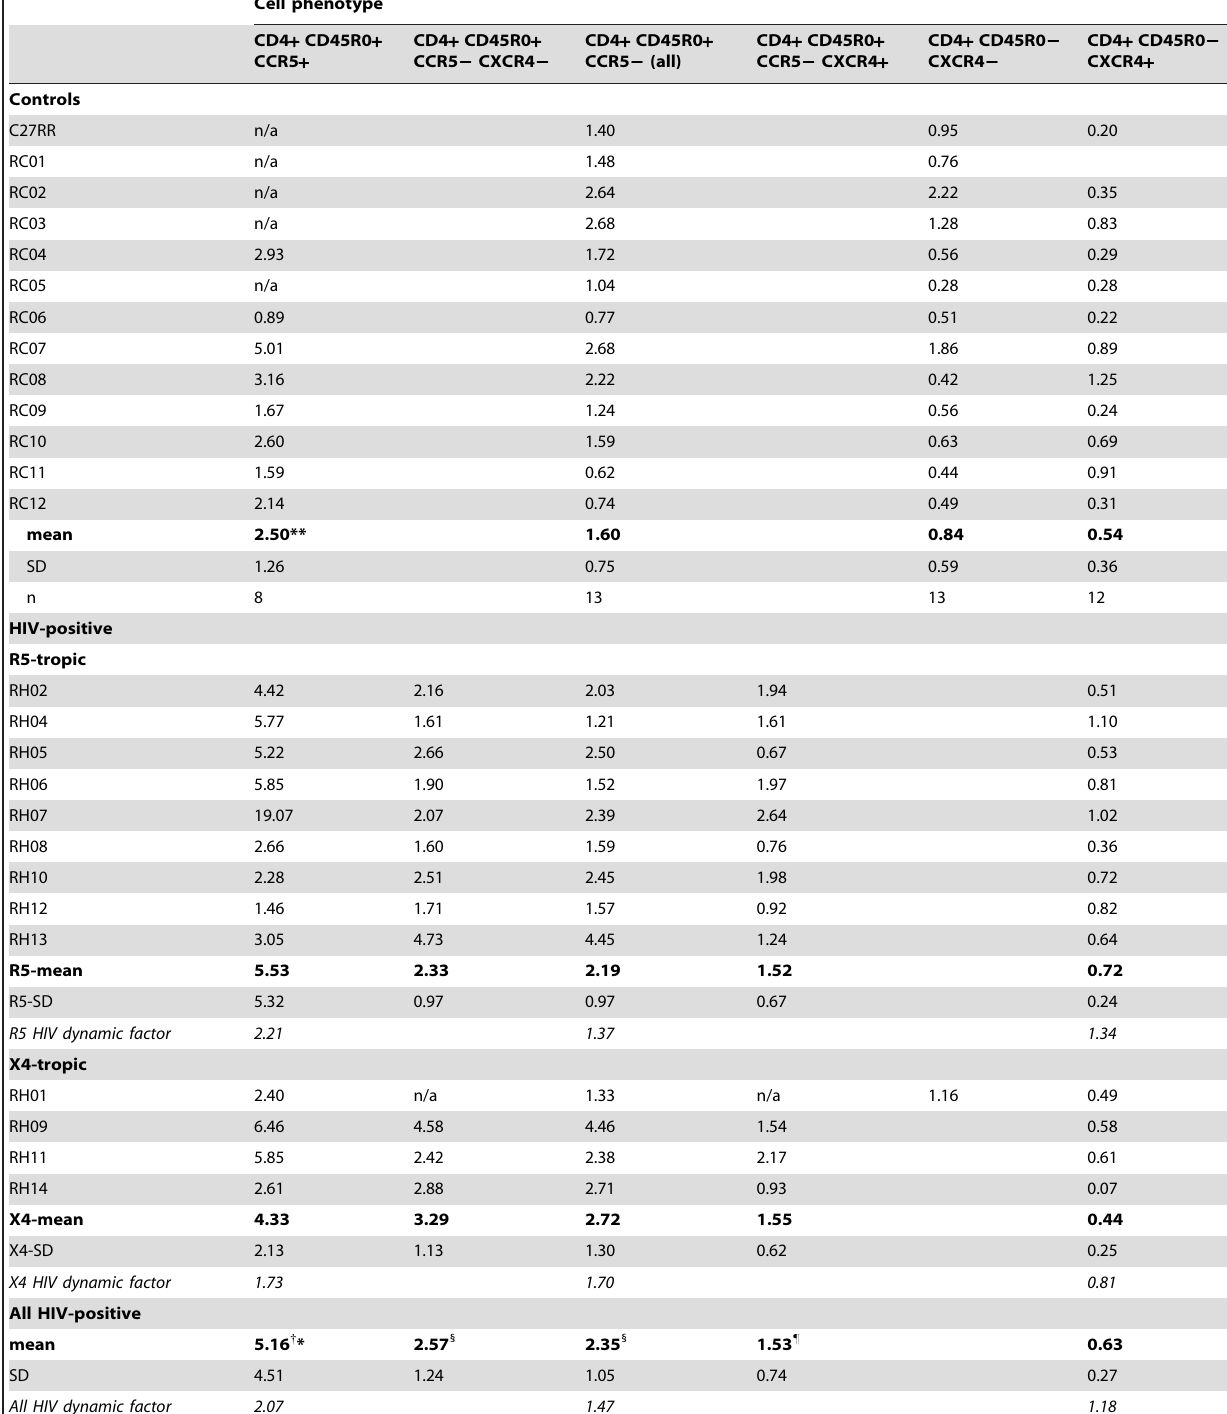
Table 2. Modeled proliferation rates for CD4 + T-cell subpopulations.